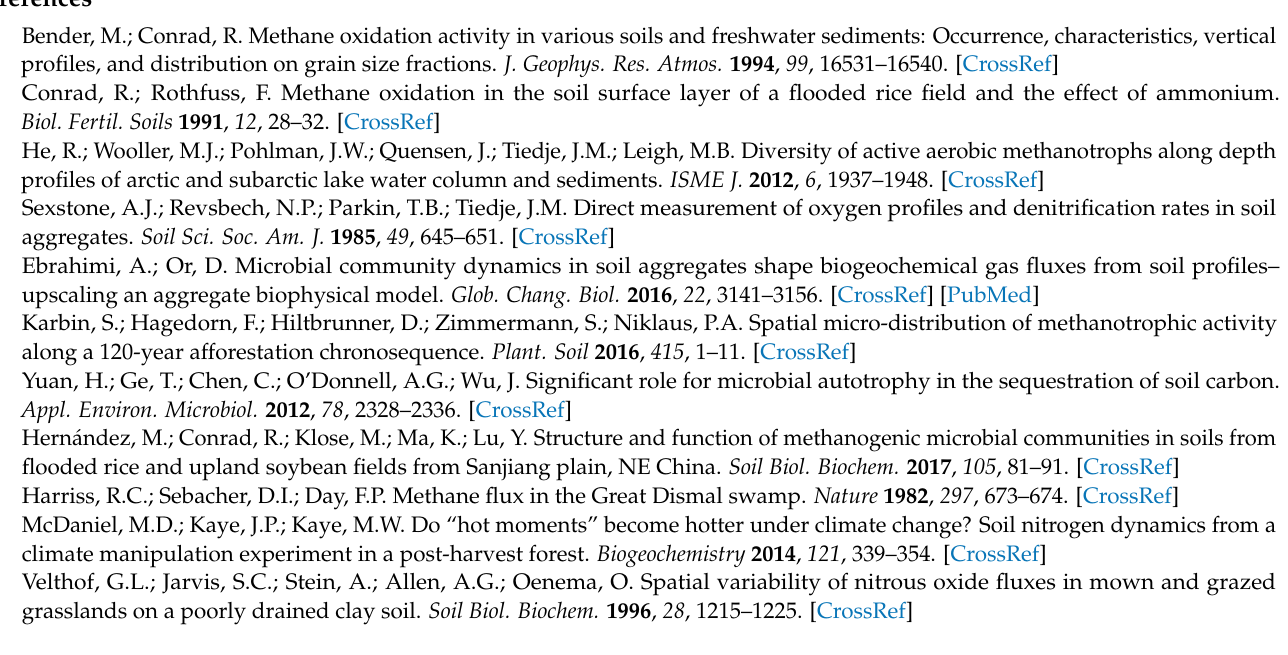
Figure S3: Bacterial 16S rRNA gene diversity measured as Shannon diversity (H’) and richness (S) ( n = 4, means ± standard errors). Figure S4: NMDS ordination of pmoA (A) and Euryarchaeota (B) communities based on the Bray–Curtis dissimilarity of community composition. Shape indicates depth and sites are colored according to the soil type. The arrows indicate the direction at which the environmental vectors fit the best (using the envfit function) onto the NMDS ordination space. Abbreviations: DOC, dissolved organic carbon; DON, dissolved organic nitrogen; EC,